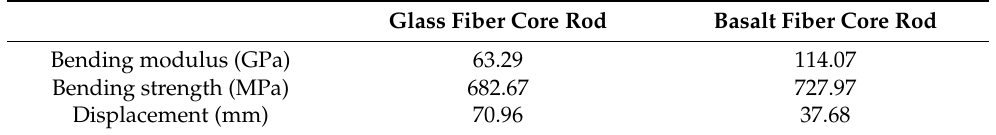
Table 1. Comparison of bending parameters between glass fiber core rods and basalt fiber core rods.